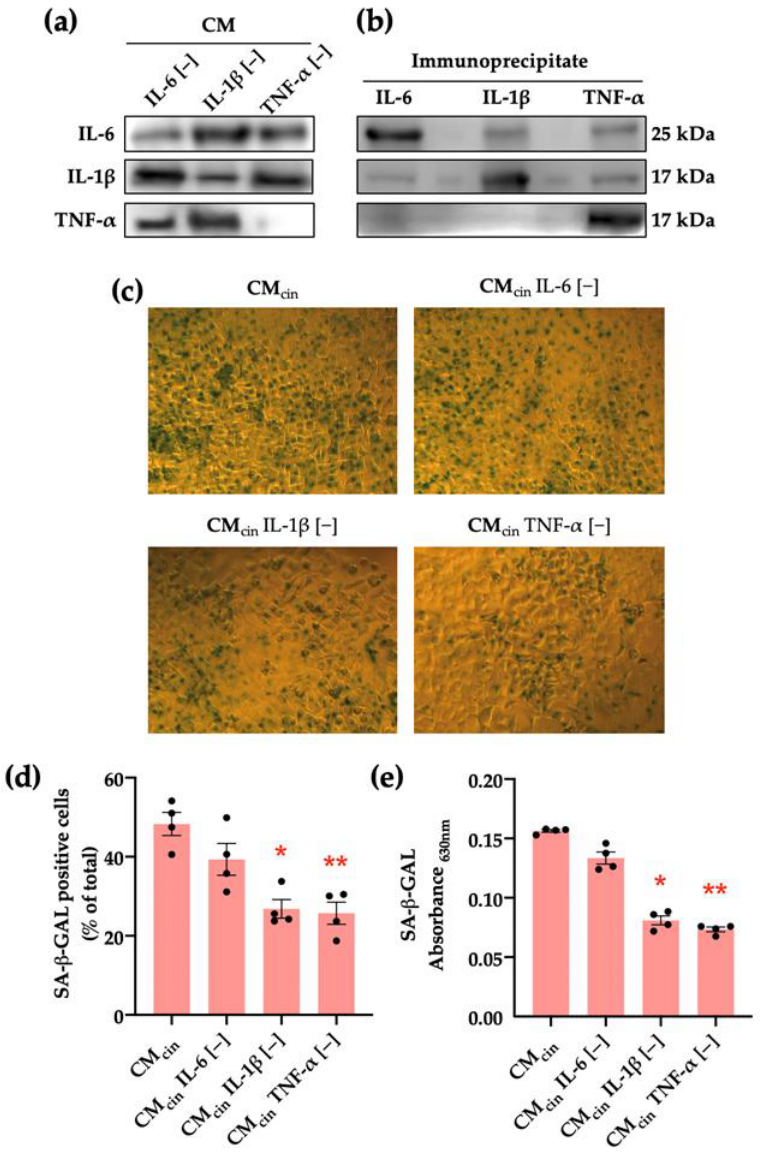
Figure 5. CaSR activation in SW872 pre-adipocytes elevates IL-1 β and TNF- α secretion, which induce cell senescence in HepG2 cells: ( a ) immunodetection of IL-6, IL-1 β , and TNF- α protein levels in CM cin after immunoprecipitation ( n = 1); ( b ) immunodetection of IL-6, IL-1 β , and TNF- α protein levels in the CM cin pellet after immunoprecipitation ( n = 1); ( c ) Representative images of SA- β -GAL staining of HepG2 cells exposed to CM cin , CM IL-6 [ − ] , CM IL- 1β [− ] , and CM TNF- α [− ] (scale bar = 100 μm); ( d ) quantification of SA- β -GAL-positive cells normalized by total cells in the field; ( e ) SA- β -GAL absorbance recorded at 630 nm. Each dot represents an individual experiment ( n = 6). * p < 0.05, and ** p < 0.01, the versus control, Friedman ’ s test, and Dunn ’ s post-hoc test.